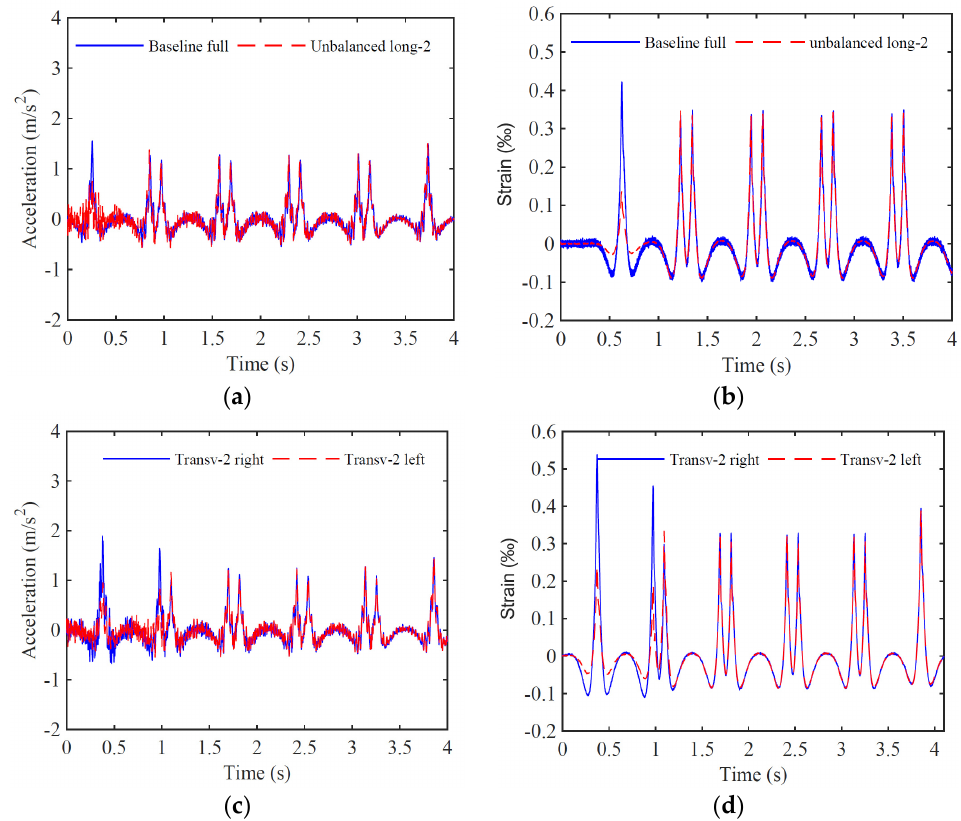
Figure 9. Time-series with accelerations ( a , c ) and strains ( b , d ) measured in position 1 for unbalanced scenarios: ( a , b ) comparison between full and longitudinal unbalanced load scheme; ( c , d ) comparison between a transverse unbalance recorded in right and left rails.